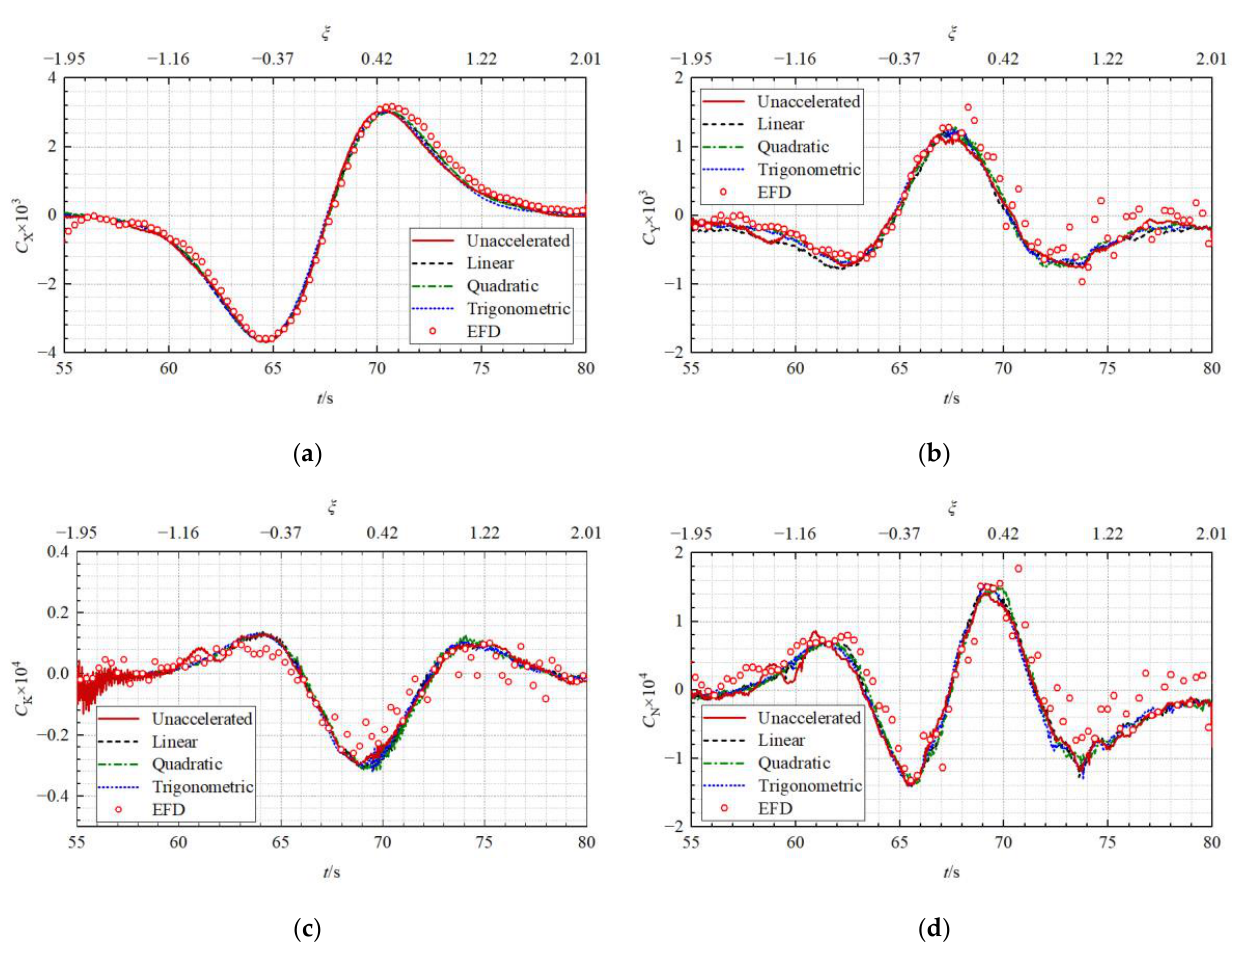
Figure 13. Time histories of the attitudes of the moored ship under the impacts of the primary wave system. ( a ) Sinkage’, ( b ) Trim’.